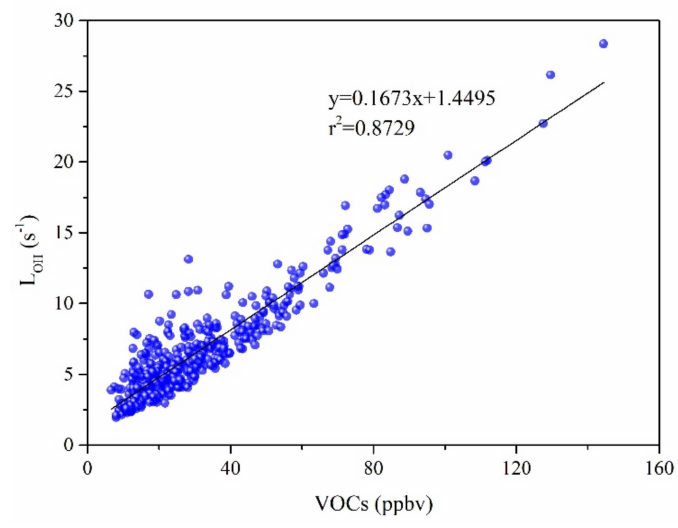
Figure 5. Correlations between mixing ratio of VOCs and L OH